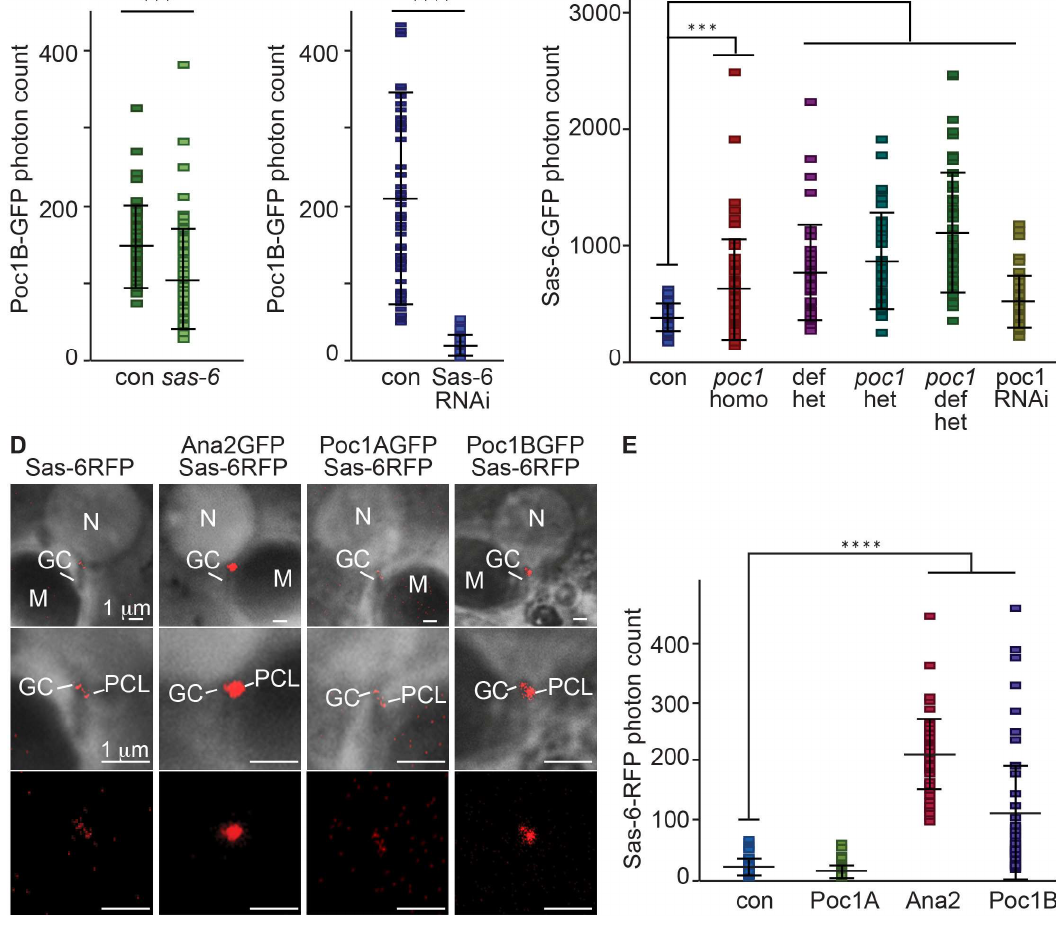
Figure 2. Poc1B is downstream to Sas-6 during PCL initiation. ( A , B ) Localization of gPoc1BGFP to the PCL was slightly reduced in sas-6 heterozygote mutant background (N = 63) compared to the control (con, (N = 46) (A) and much more reduced in sas-6 RNAi background (N = 72) (B) compared to control (con, N = 52). gPoc1BGFP was expressed using endogenous promoter. ( C ) Sas6GFP localization to the PCL was significantly increased in poc1 W87X homozygote mutant (N = 55), Poc1 deficiency (Df(3R)ED5066) transheterozygote (N = 43), poc1 W87X heterozygote (N = 42), poc1 deficiency with poc1 W87X (N = 55), and Poc1 RNAi(P{KK102200}VIE-260B) (N = 58) background compared to the control (con, N = 44). Sas6GFP was expressed using ubiquitin promoter. ( D , E ) Sas6RFP localization to the PCL was significantly increased in Ana2GFP (N = 44) and Poc1BGFP (N = 42) overexpressing flies but not in Poc1AGFP overexpressing flies (N = 70) or the control (con, N = 61) (D). Quantification of Figure 2D ( E ). Sas6RFP was expressed using ubiquitin promoter. All images and quantification data were obtained by live cell imaging. Con, Control; Het, Heterozygote; Homo, Homozygote; OE, Overexpression. *** p < 0.001. **** p < 0.0001